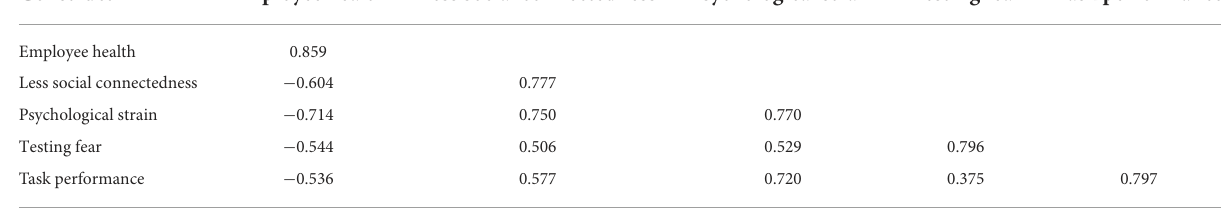
TABLE 2 Discriminant validity (Fornell-Larker-1981 Criteria).